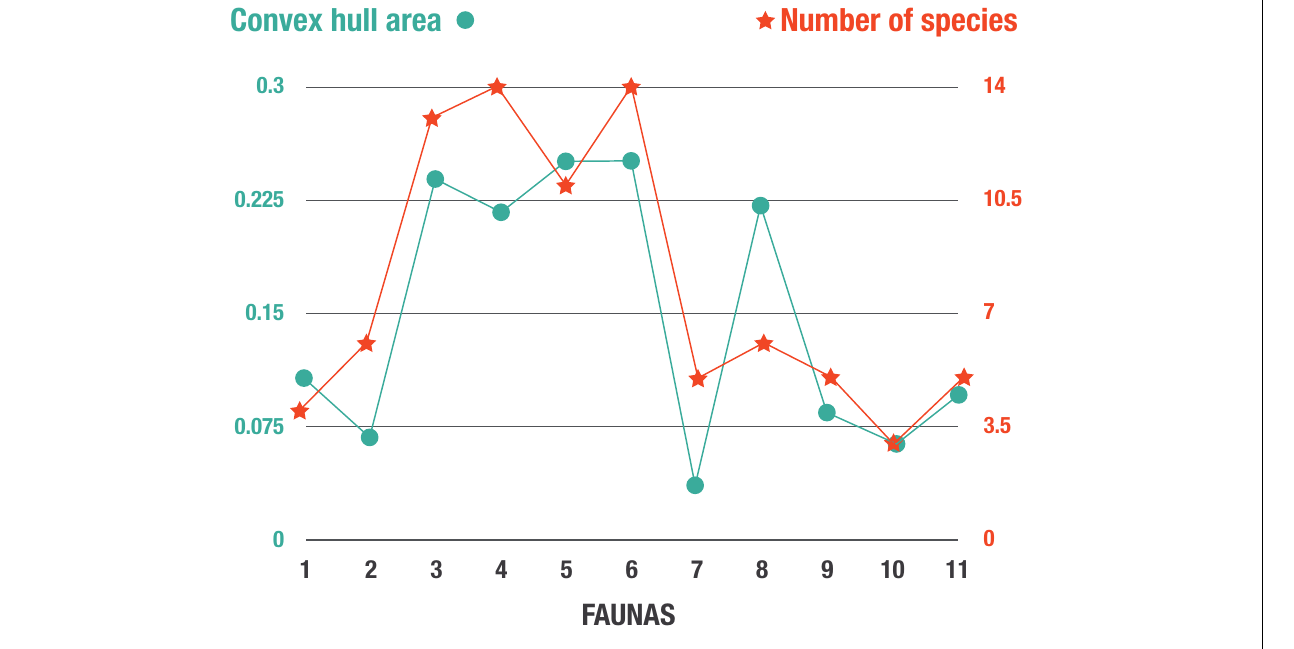
least disparate and diverse faunas (with the exception of fauna 1-Morava Ranch